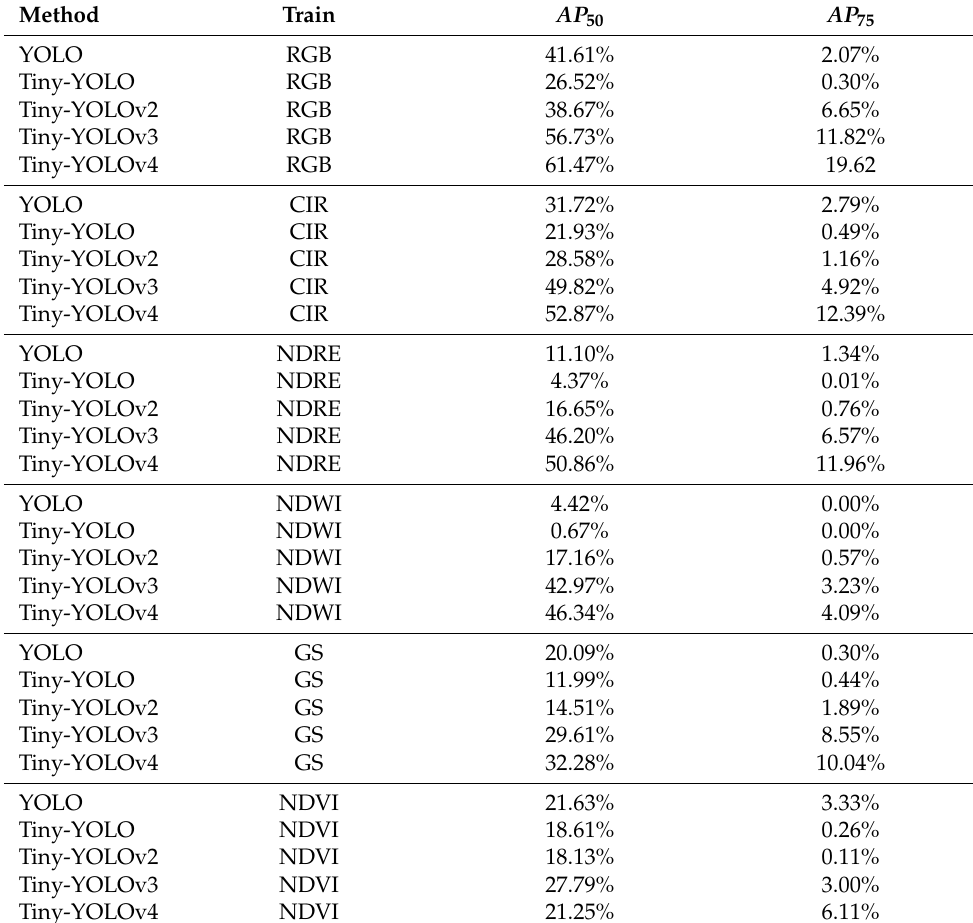
Table 3. Regression based networks training. AP 50 : average precision with IoU of 0.5; AP 75 : average precision with IoU of 0.75; Train: dataset used in training; Method: Network used for